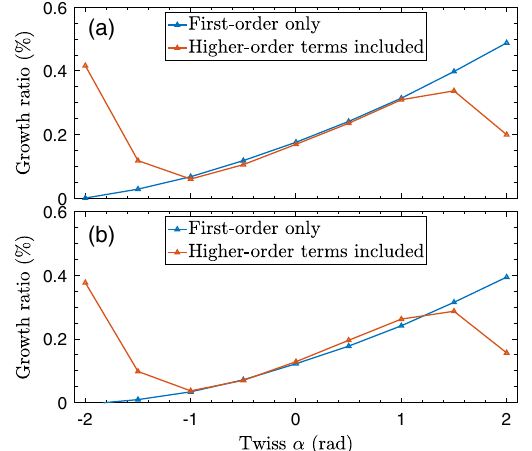
FIG. 16. Emittance growth ratio due to the CSR effect for (a) a flat-top distribution and (b) a parabolic distribution. The blue curve indicates the ratio estimated with the first-order matrix. The orange curve is the ratio calculated by including the higher-order terms of the transfer